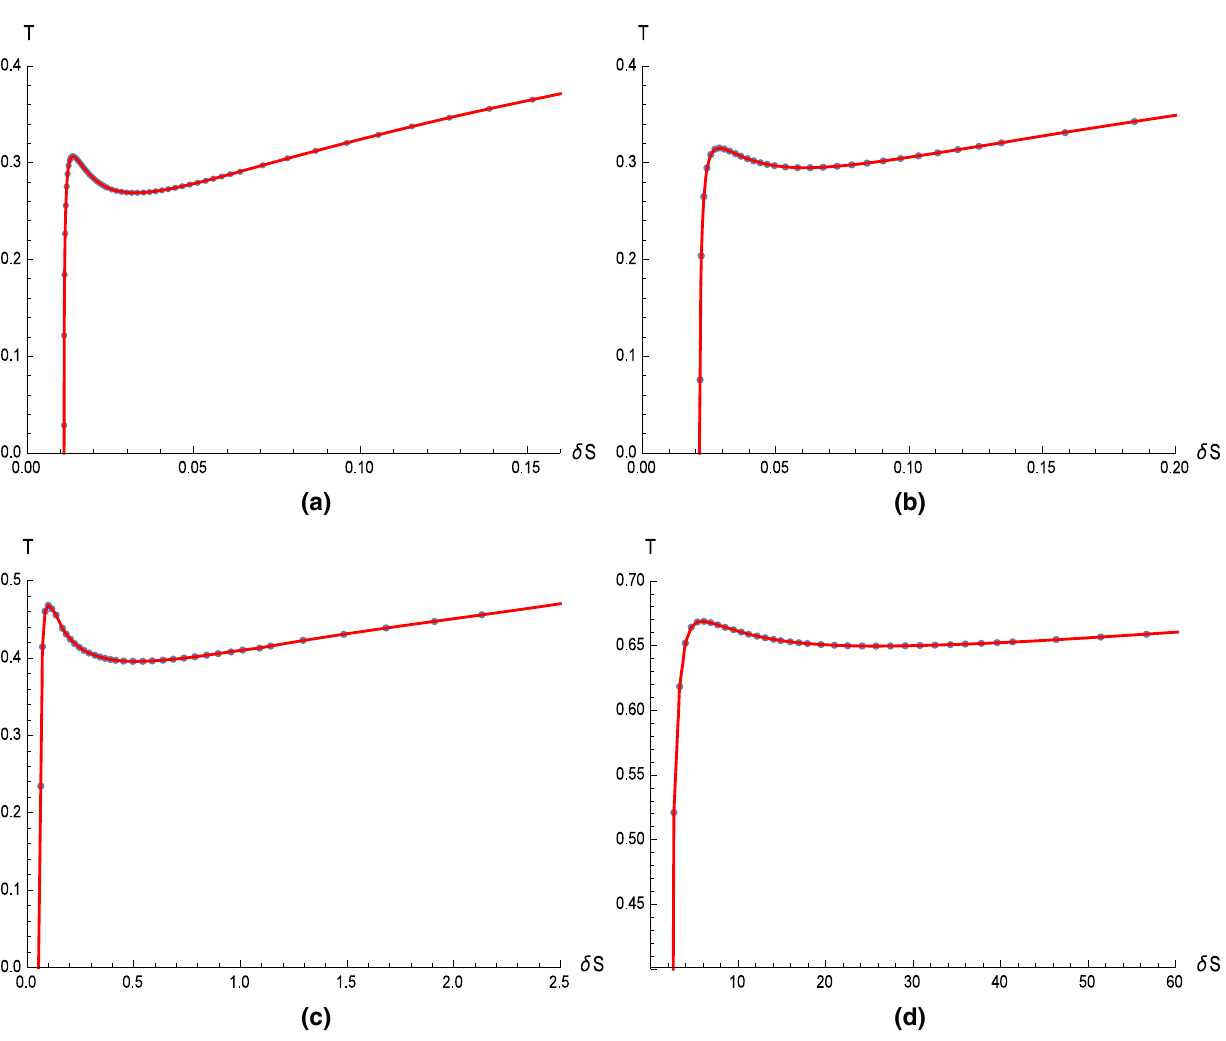
Fig. 7 T vs. δ S for n = 3 ,θ 0 = 0 . 2. a α = 0 , q = 0 . 12, b α = 0 . 25 , q = 0 . 12, c α = 0 . 5 , q = 0 . 06, d α = 0 . 75 , q = 0 .